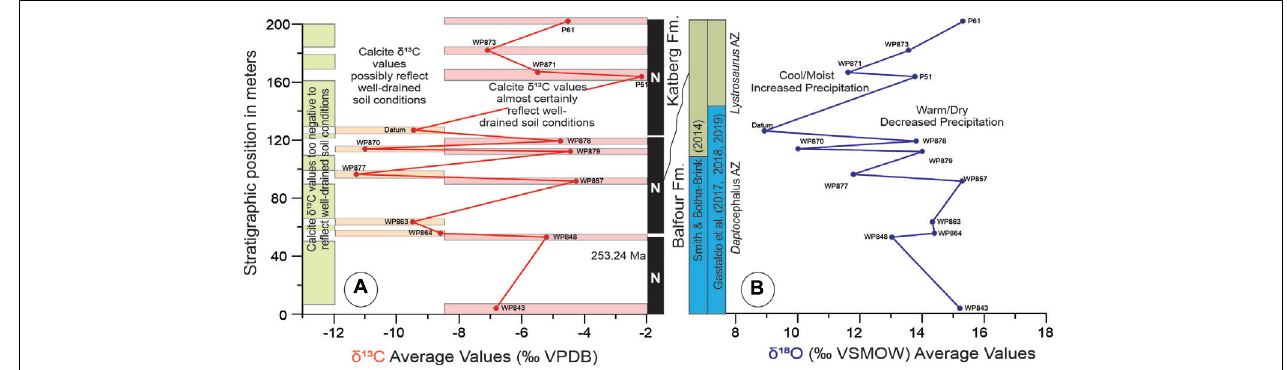
FIGURE 10 | Stratigraphic trends of mean values of δ 13 CVPDB (A) and δ 18 OVSMOW (B) derived from pedogenic nodules formed in “ghost” landscapes plotted against published magnetostratigraphy (Gastaldo et al., 2018) and models of vertebrate biostratigraphy in geochronometric context (Gastaldo et al., 2015) demonstrating cyclicity in seasonally wet (represented by green rectangles) and seasonally dry landscapes (represented by orange and reddish rectangles). This trend is similar to that at Wapadsberg Pass (Gastaldo et al., 2014, 2020b) and shows an overall wetting trend towards the boundary between the Daptocephalus and Lystrosaurus AZs rather than a unidirectional warming as reported by other workers (Ward et al., 2005; Smith and Botha-Brink, 2014; Rey et al., 2016; Botha et al.,